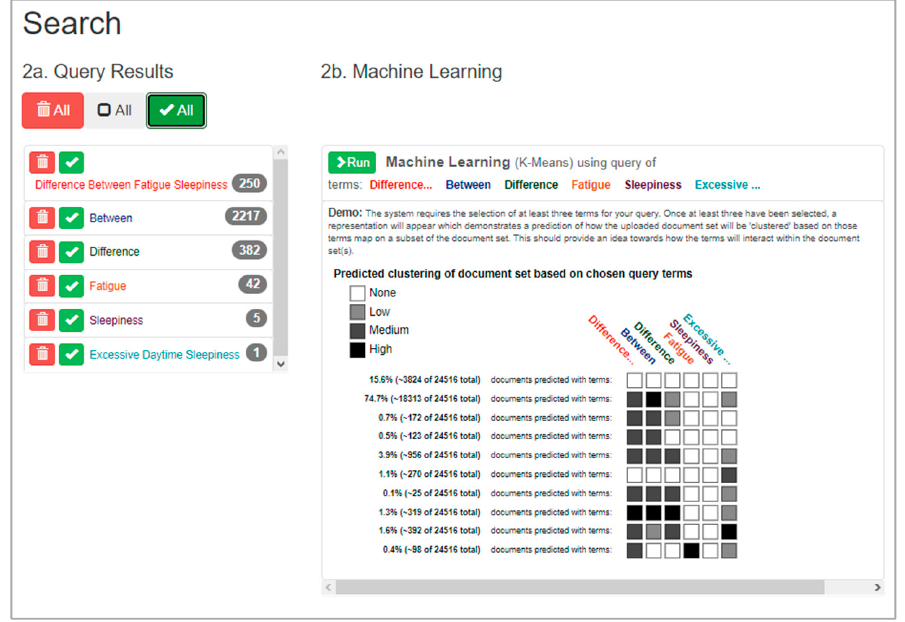
Figure 9. A preview of a search formulation that uses all query items.